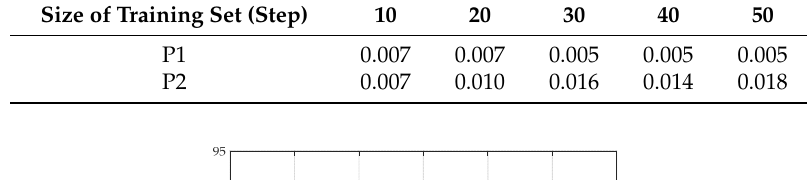
Table 3. P values of the paired t -test of different sizes of training set.